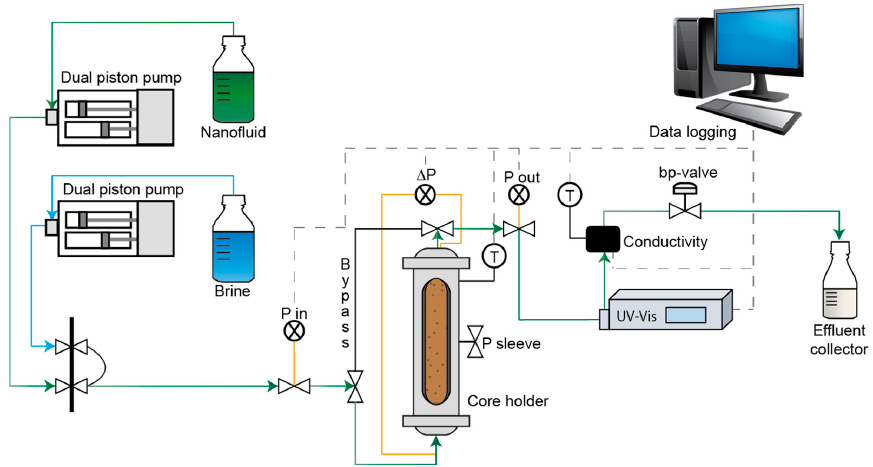
Figure 7. Schematic of the experimental setup used for core plug retention flood.